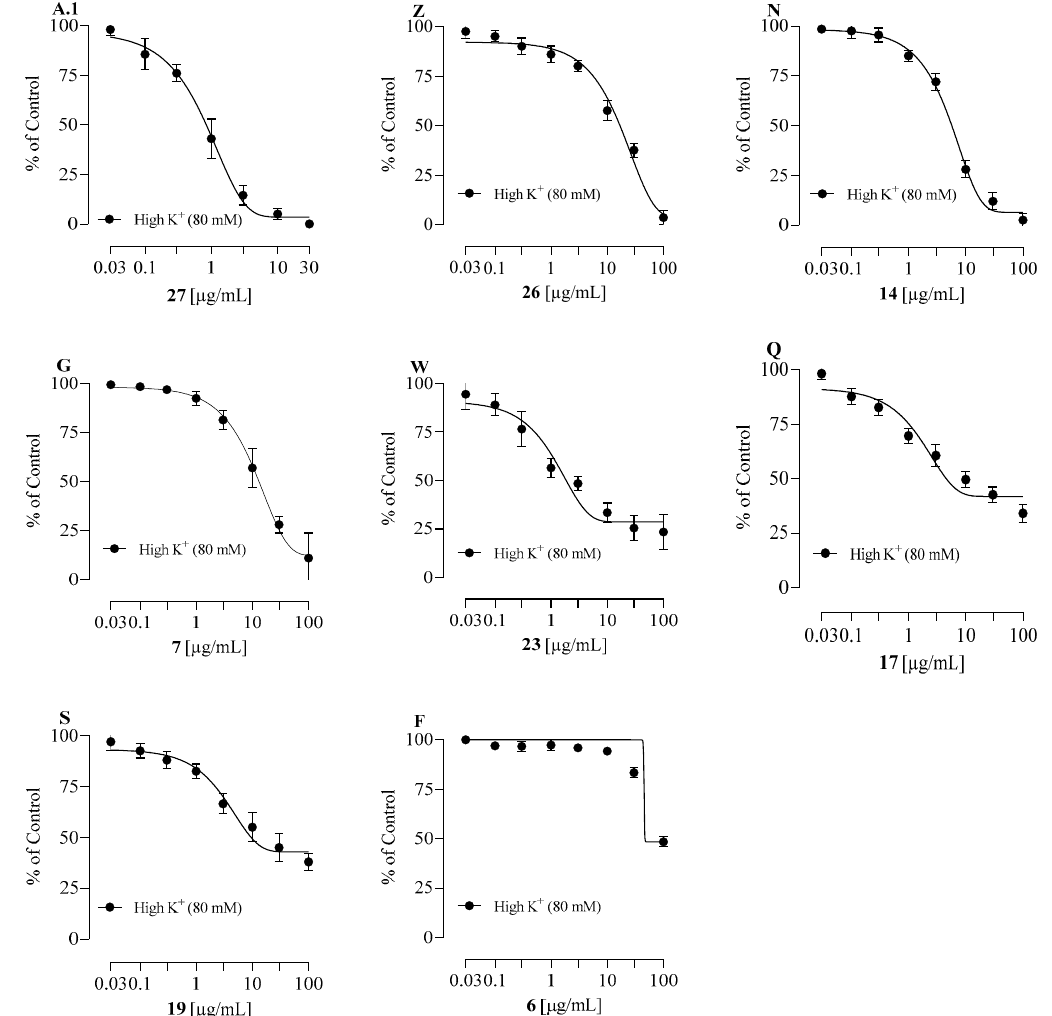
Figure 1. The effect of synthesized compounds 27 (A.1), 26 (Z), 14 (N), 7 (G), 23 (W), 17 (Q), 19 (S), and 6 (F) against high K + (80 mM)-induced contraction (n = 3–5), values represented as mean ± SEM using two-way ANOVA.